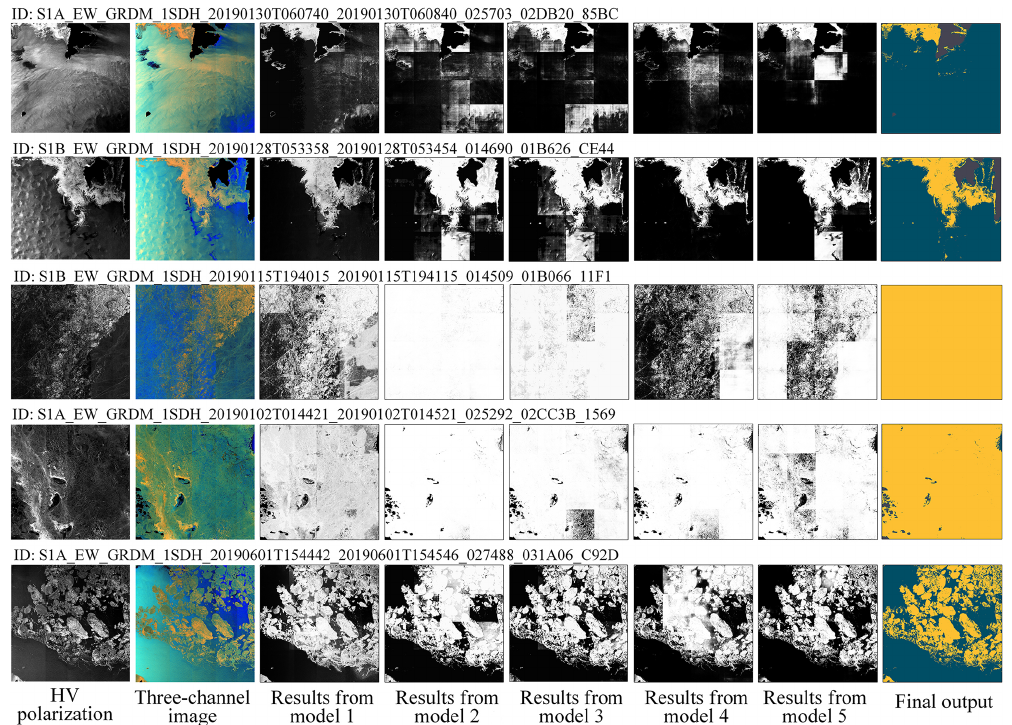
Figure 9. Five cases illustrating the combination of selected U-Net classifiers into the integrated stacking model. The first two columns are S1 images in HV polarization and the corresponding input RGB false-color composites. The following five columns are the outputs from the five classifiers selected with diverse specializations, and the last column is the final output of sea ice cover (yellow, cyan, and gray represent sea ice, open water, and land,